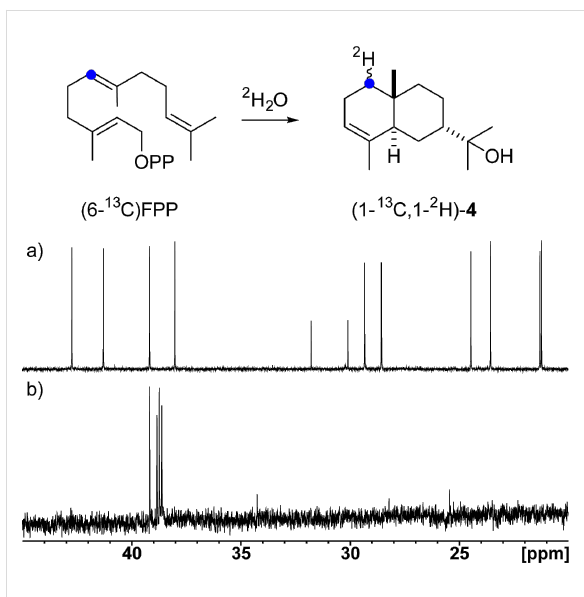
Figure 4: Incubation experiments with (6- 13 C)FPP and the 7- epi - α - eudesmol synthase in deuterium oxide. a) 13 C NMR spectrum of unla- belled 4 and b) 13 C NMR spectrum of the extract from the incubation experiment with (6- 13 C)FPP in 2 H 2